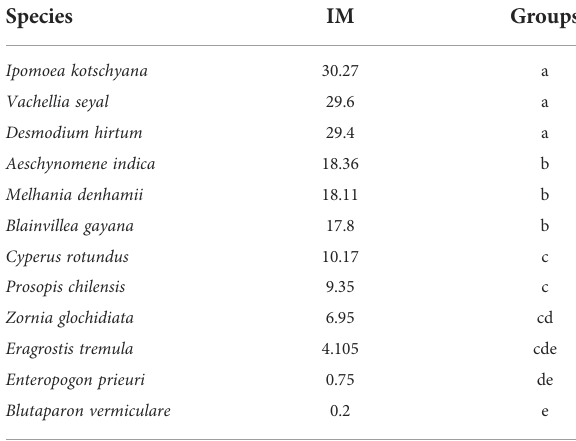
TABLE 10 Tree – herb grouping as a function of intensities of mycorrhization of living root. Species IM